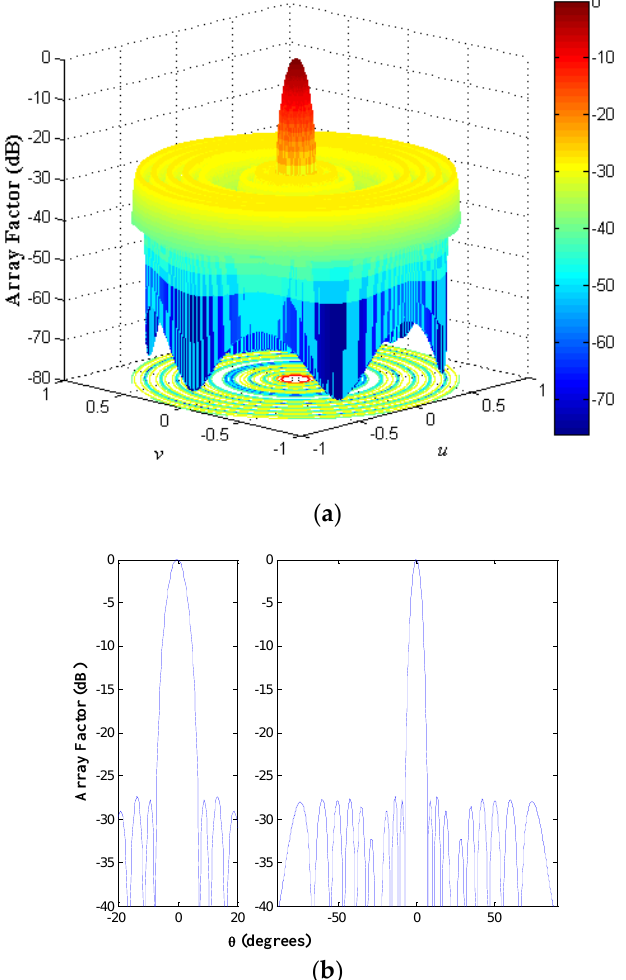
Figure 7. ( a ) Array factor and ( b ) cut of the array factor at φ = 0 ° for the antenna array configuration illustrated in Figure 6.